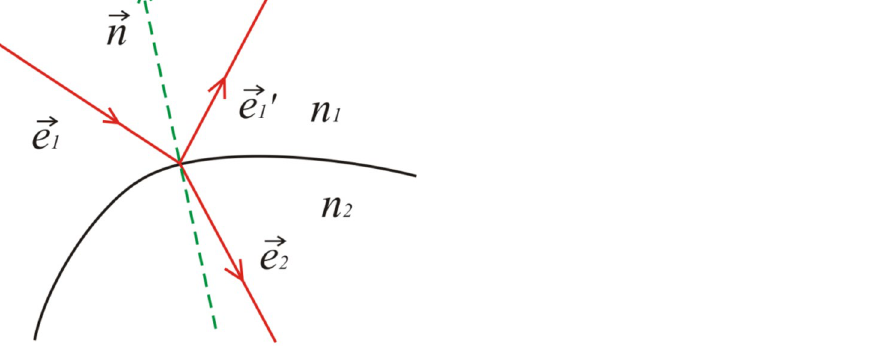
Figure 4. Schematic presentation of reflection and refraction of light wave at the interface of two